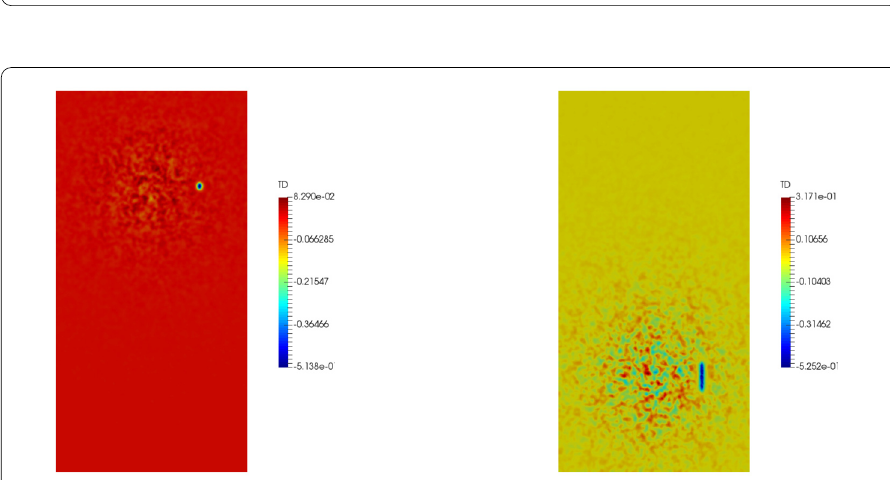
Figure 10 Topological derivative on Γ front for ten combined frequencies. Left: topological derivative combining ten linearly-spaced frequencies between 0.8 and 2 Hz. Right: zoom of the previous image around the groove-shaped defect with the colormap rescaled to the visible range. The outline of the defect is also shown in black on the image on the right